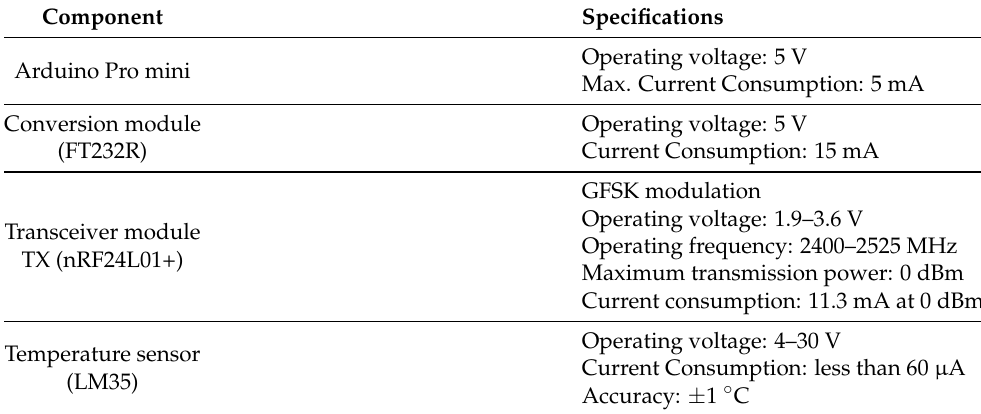
Table 3. TX Node